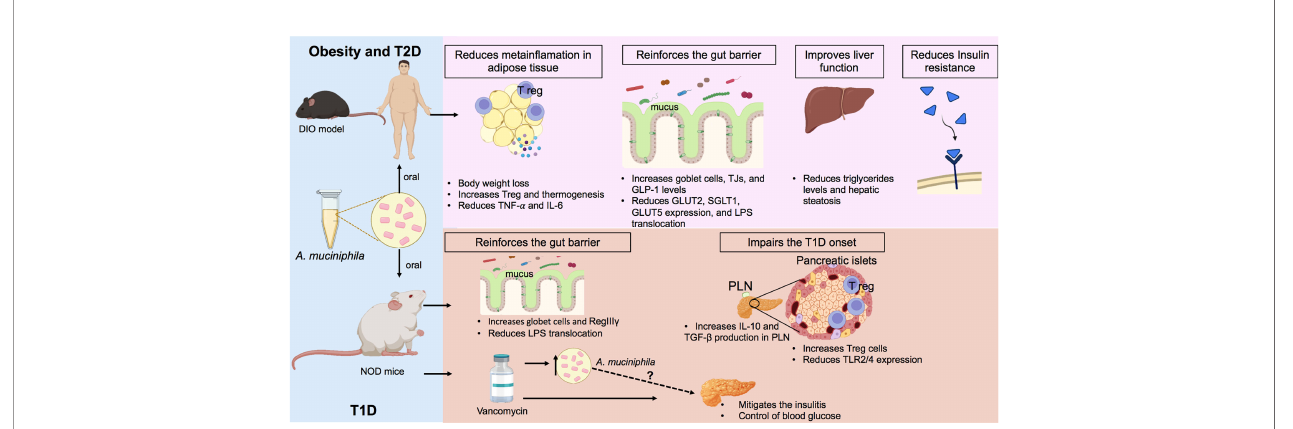
FIGURE 1 | Regulatory effects of A. muciniphila on obesity, T2D, and T1D. In the models of diet-induced obesity (DIO), oral treatment with A. muciniphila reduces weight gain, controls fat accumulation, increases regulatory T cells (T regs), and decreases the production of pro-in fl ammatory cytokines in the adipose tissue of mice fed with a high-fat diet (HFD). In the intestine, this probiotic increases goblet cells and mucus production, in addition to inducing a greater production of glucagon-like peptide-1 (GLP-1), which controls glucose absorption. The administration of pasteurized A. muciniphila to obese subjects decreased body weight and hip circumference, improved insulin sensitivity, and reduced the markers of liver damage. In NOD mice, the model of T1D (autoimmune), A. muciniphila improved mucus production and increased the antimicrobial peptide RegIII g , which contributes to improved intestinal barrier function and the lower translocation of LPS into the circulation. In parallel, the probiotic increases the production of anti-in fl ammatory cytokines in pancreatic lymph nodes (PLNs) and potentiates the recruitment of T regs in the pancreas, culminating in a delay in the development of T1D. Vancomycin-treated NOD mice showed an enrichment of A. muciniphila in the gut, which is correlated with a lower degree of insulitis and glycemic control. Figure created with BioRender.com. TNF- a : tumor necrosis factor- a ; IL-6: interleukin-6, GLP-1: glucagon-like peptide-1; GLUT2, glucose transporter 2; SGLT1, sodium-glucose cotransporter 1; GLUT5, glucose transporter 5; RegIII g : regeneration islet-derived III, IL-10: inyerleukin-10; TGF- b , transforming growth factor beta; TLR2/4, Toll-like receptor 2/4; TJs, tight